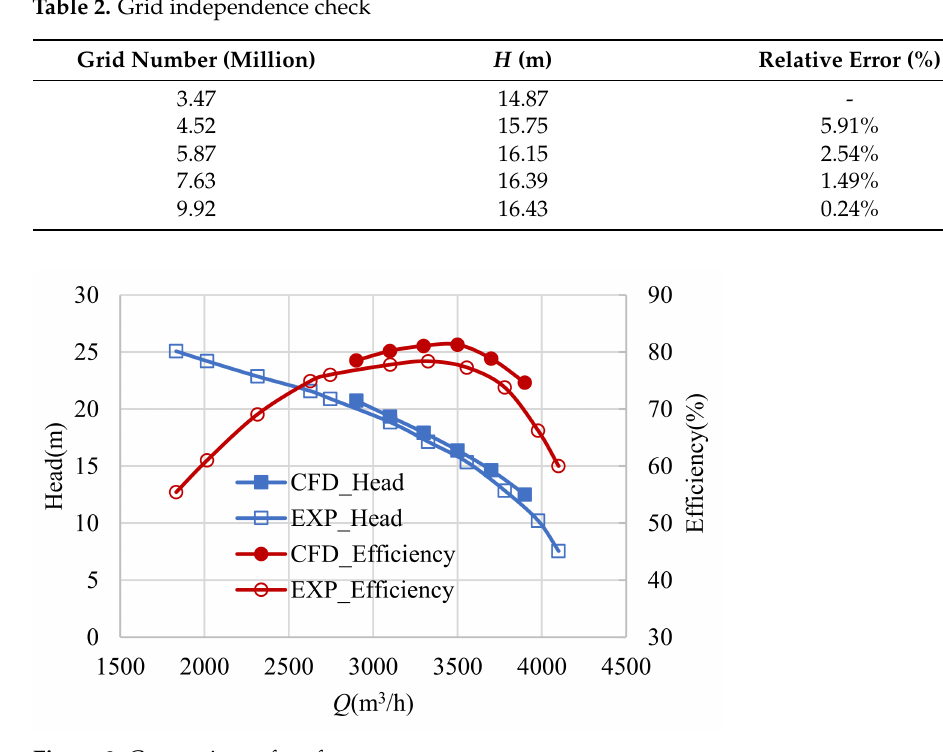
Figure 3. Comparison of performance